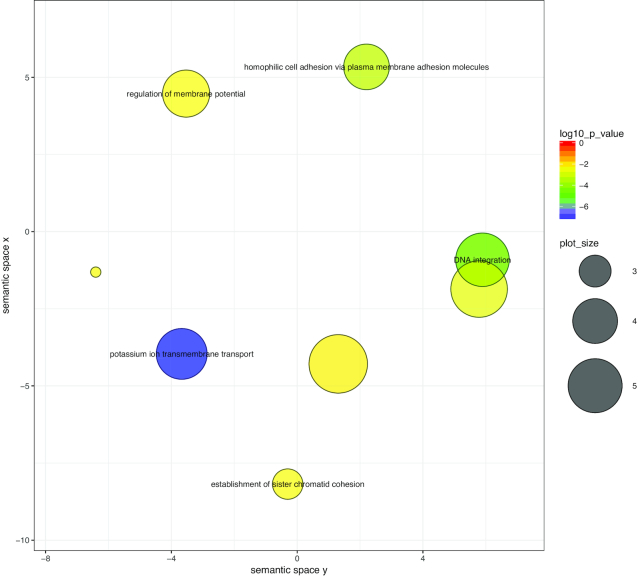
Gene ontology biological processes over-enriched within Acraspeda-specific orthogroups visualized using ReViGO. Over-representation analysis was performed with ClusterProfiler, with a P-adjusted cutoff of 0.01. Color indicates log10-transformed P-adjusted value. Terms are plotted within an x-y semantic space, in which similar terms are clustered within closer proximities. Color indicates P-value and circle size indicates frequency of GO term in the Cassiopea database.